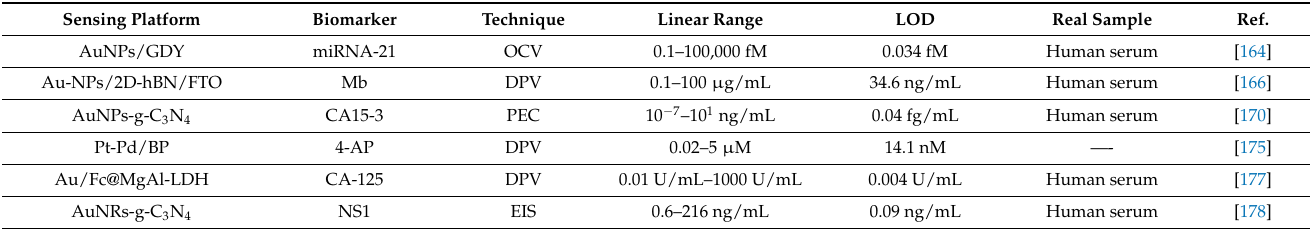
Table 5. Recent literature reports on biomarker detection based on various metal nanoparticles decorated 2D